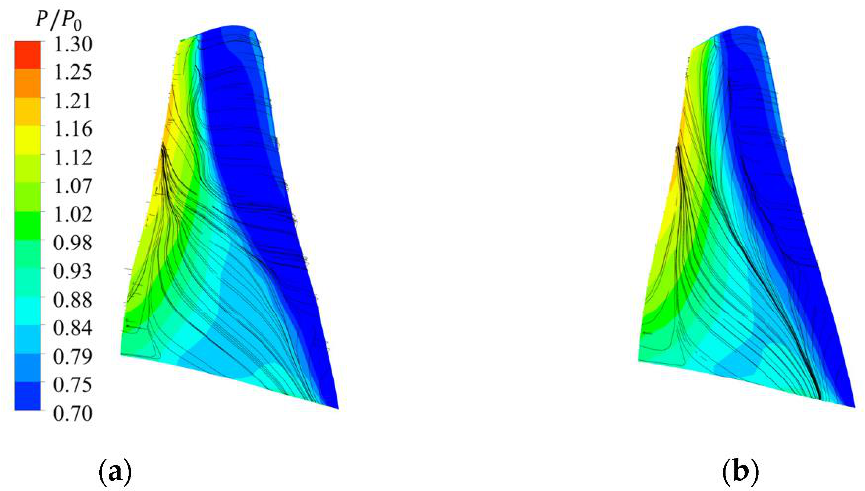
Figure 24. Comparison of the pressure distribution on the suction surface of the rotor blade. ( a ) DIS case; ( b ) COUP case.